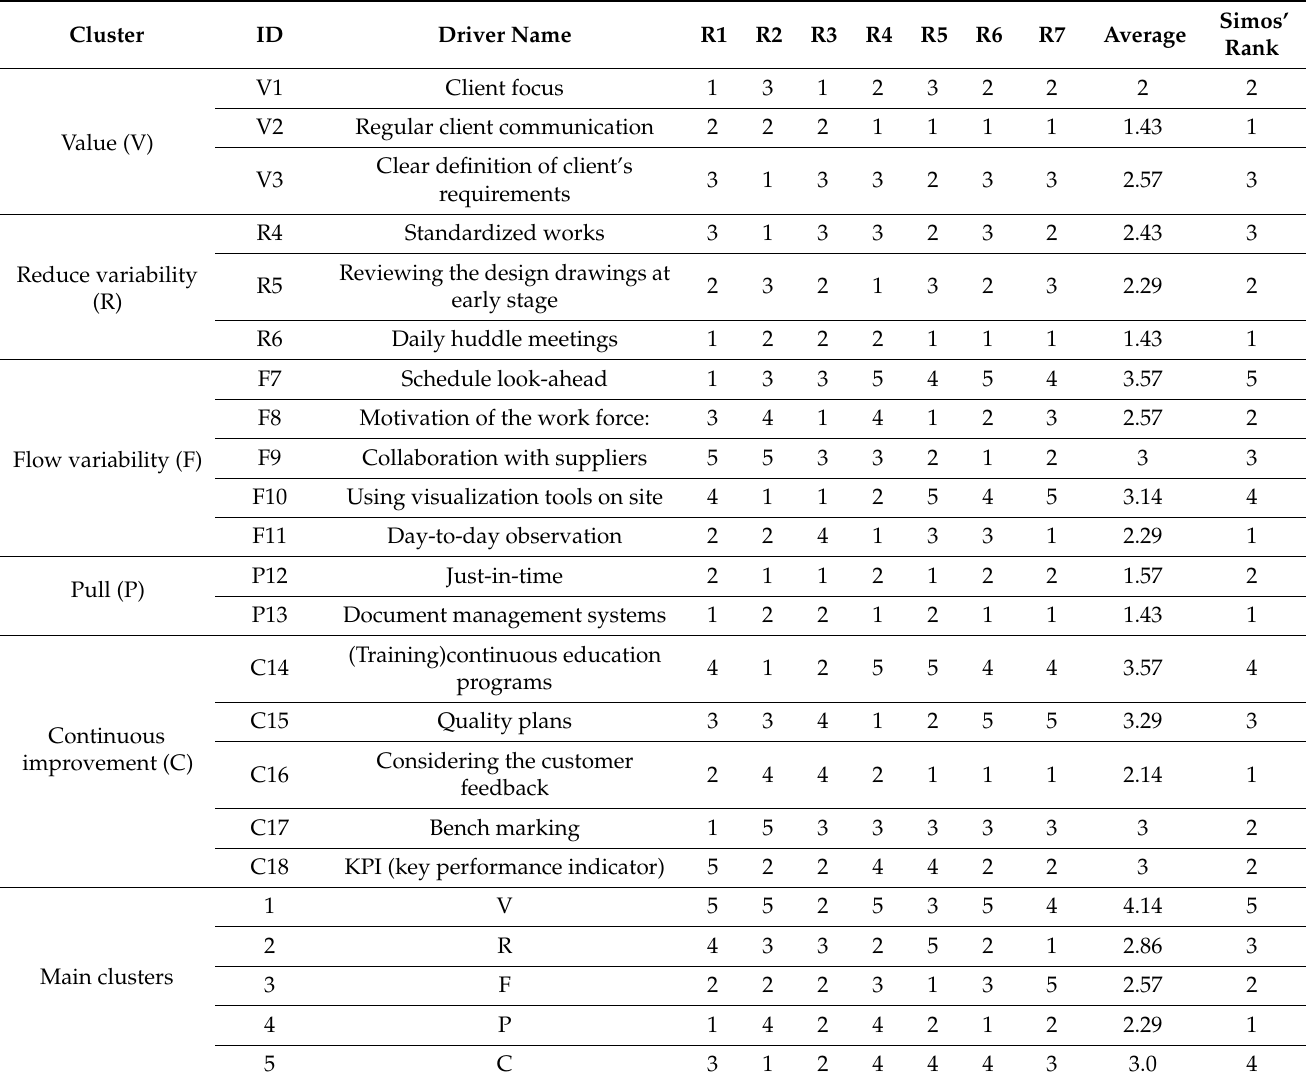
Table 2. Expert’s